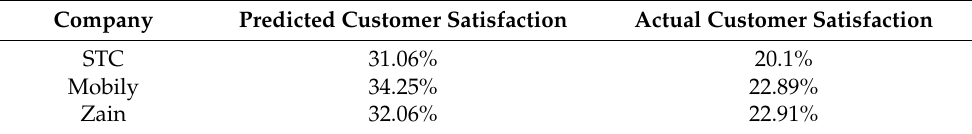
Table 7. Customer satisfaction rate vs. actual customer